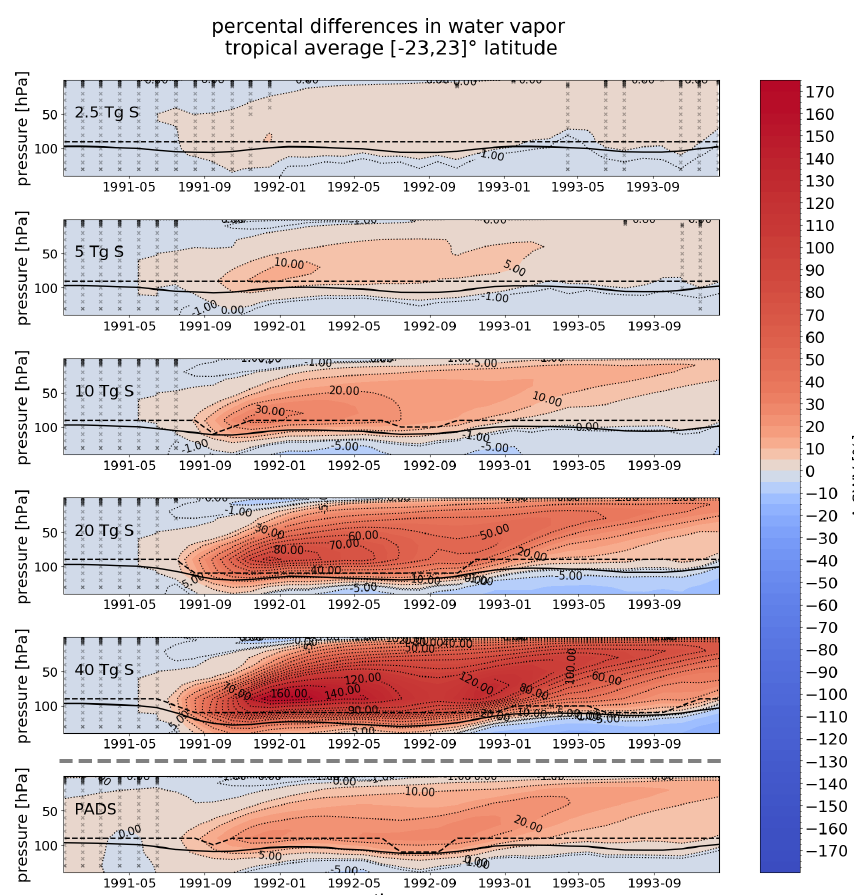
Figure B1. Percental difference in water vapor above 140hPa in the tropical average over [− 23 , 23 ] ◦ latitude for the pure sulfur injections of EVAens (2.5, 5, 10, 20 and 40Tg S). The lowermost panel shows the MPI-GE historical simulations for Mt. Pinatubo using the PADS forcing data set. The height of the WMO tropopause is indicated by a black line; the cold-point pressure is indicated by a dashed black line. In regions not covered by black crosses, statistically significant differences between stratospheric water vapor values of the perturbed and unperturbed runs ( t test at p = 0 . 05) were